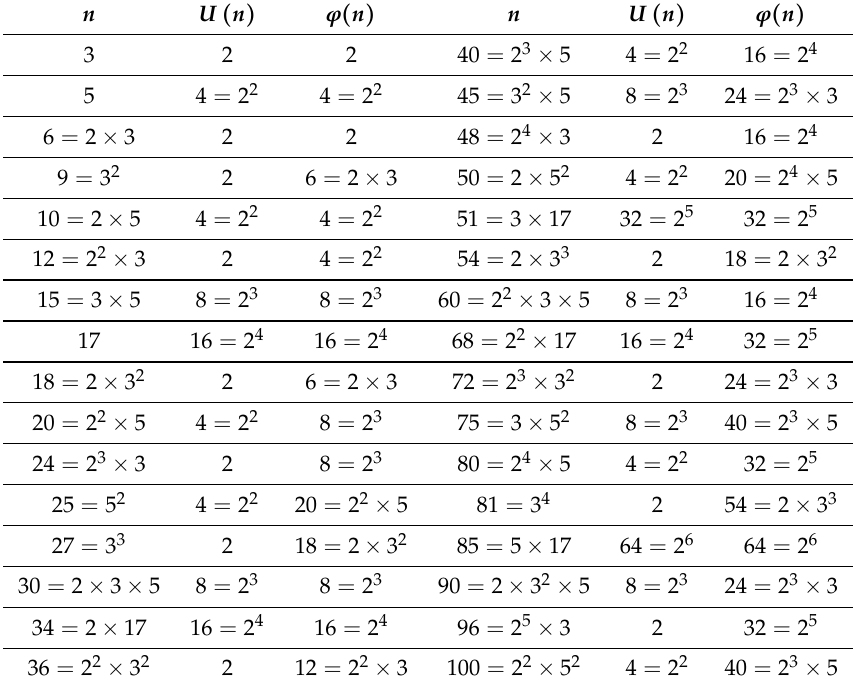
Table A2. Values of n = 2 k p 1 p 2 ... p i , U ( n ) , ϕ ( n ) with Ord 2 ( n ) =